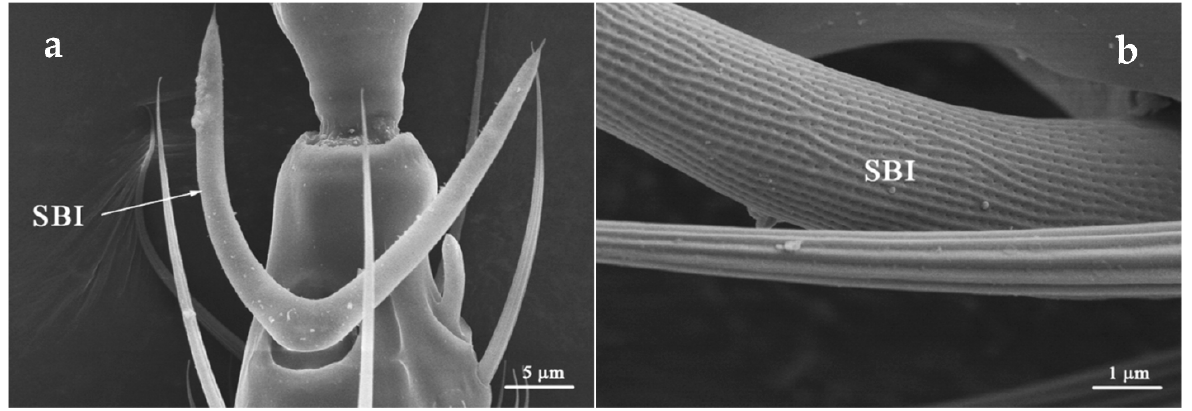
Figure 3. Sensilla basiconica I (SBI) is located at the flagellum II apex with holes on its surface. SBI of O. loti ( a ) and S. kaszabi ( b ) is shown.